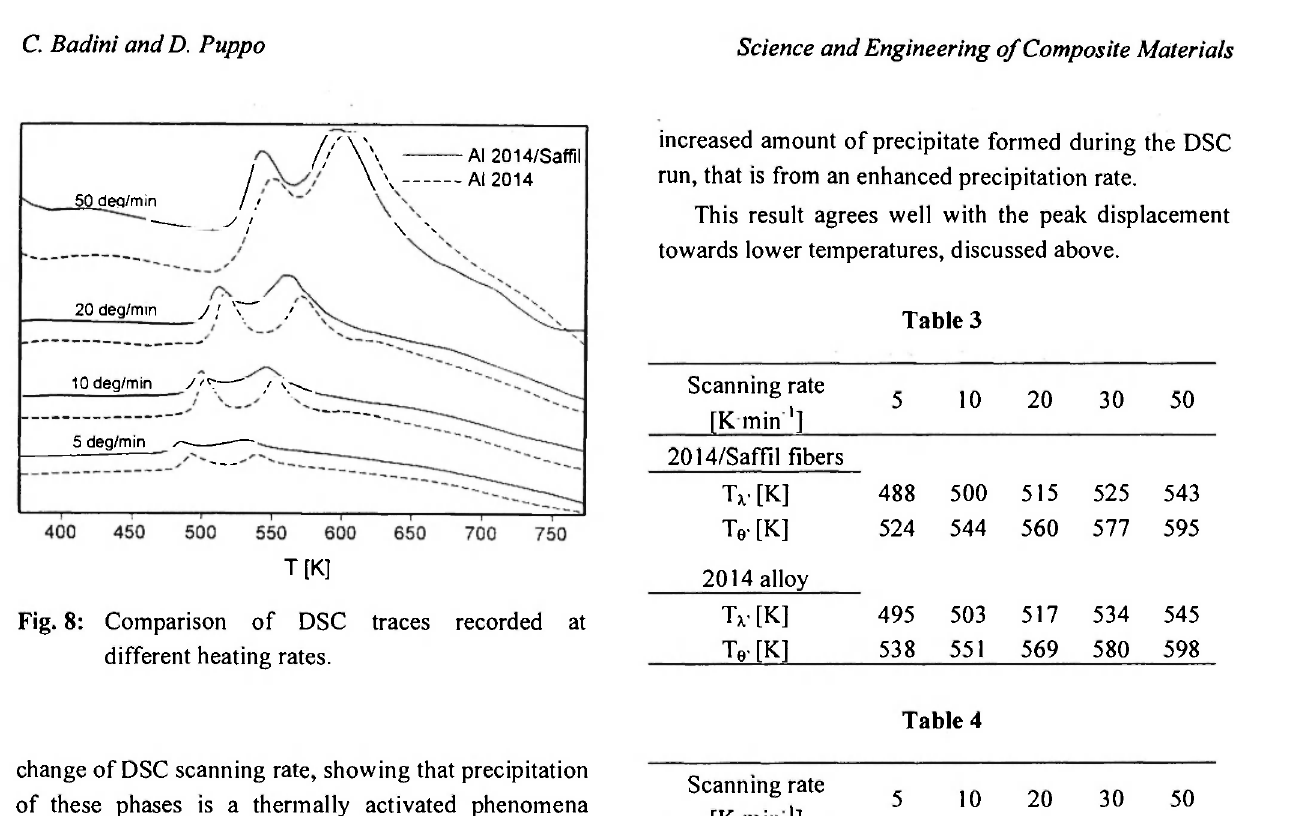
Fig. 8: Comparison of DSC traces recorded at different heating